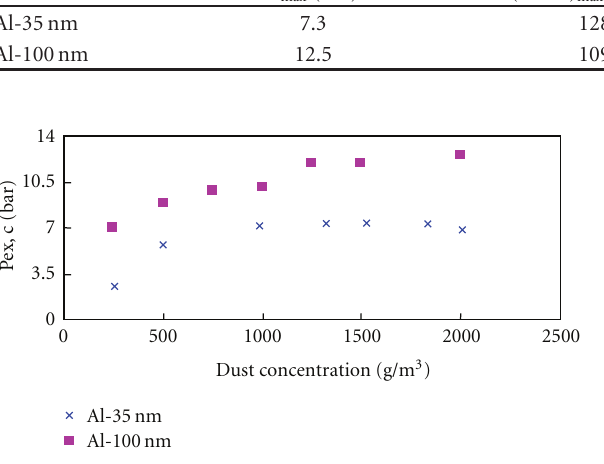
) powders. (cid:0) Figure 5: MEC test measurements for 35nm Al ( × ) and 100nm Al ) ( (cid:0)